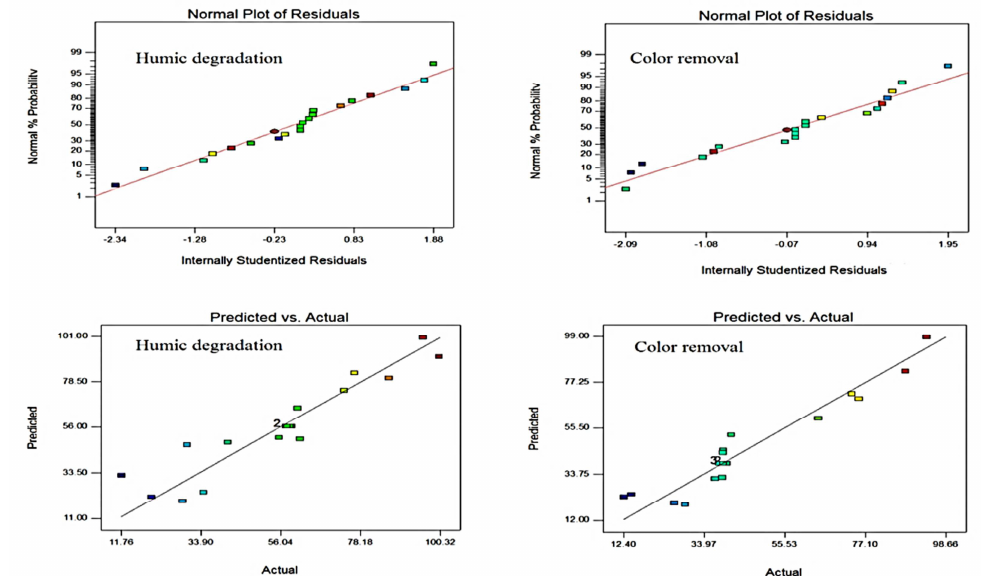
Figure 2. Normal probability and predicted vs. actual values plots for